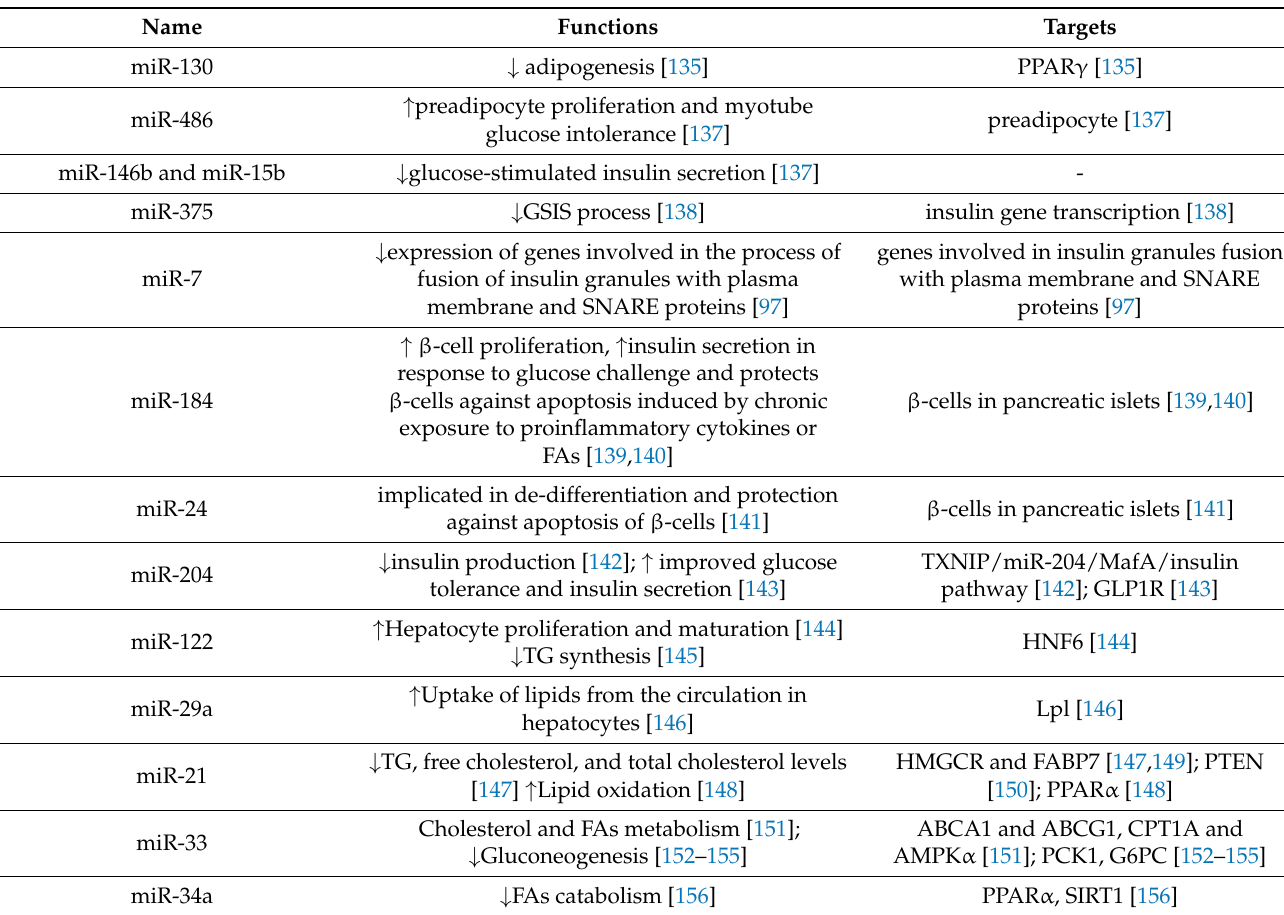
Table 2. Summary of the cited miRNAs involved in metabolic diseases and their mechanisms of